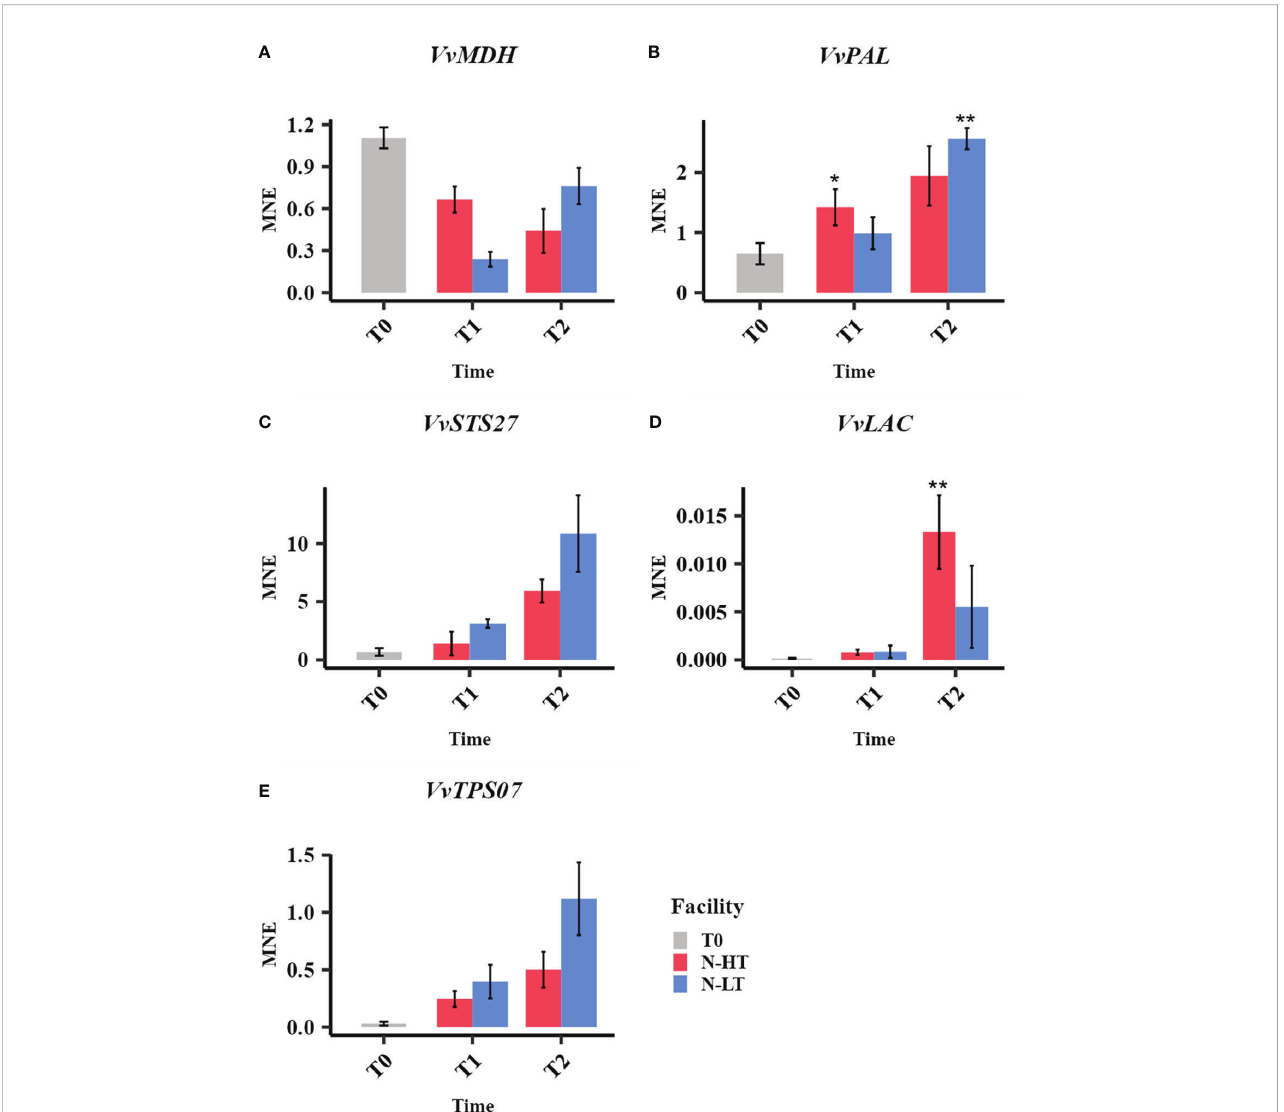
FIGURE 9 Expression pro fi les of malate dehydrogenase ( VvMDH , A ), phenylalanine ammonia-lyases ( VvPAL , B ), stilbene synthase ( VvSTS27 , C ) laccase ( VvLAC , D ) and terpen synthase ( VvTPS07 , E ) genes in grape sampled during withering in the N-HT and N-LT rooms. Error bars represent standard errors (n=3). Light blue colour indicates the N-LT condition; light red colour the N-HT condition. Asterisks represent statistically signi fi cant difference between partially withered grapes (T1 and/or T2) and grapes at harvest (T0), based on t-test (p ≤ 0.05 = *; p ≤ 0.01 =